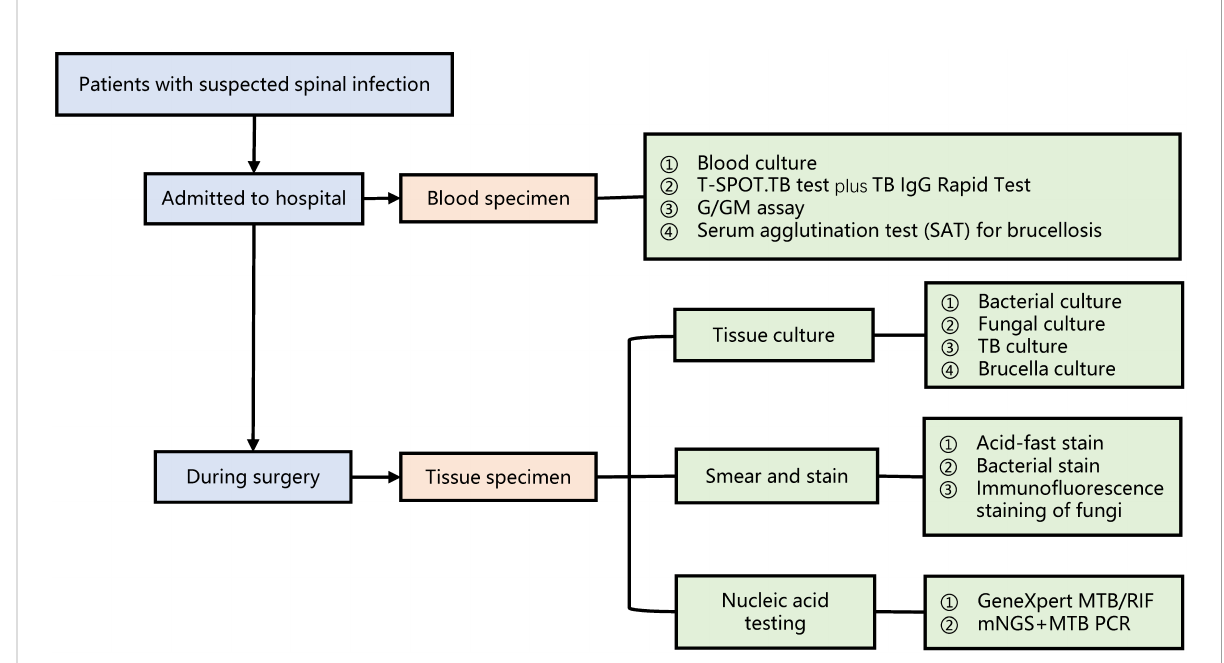
FIGURE 1 The work fl ow of specimen collection and test methods possibly involved in the